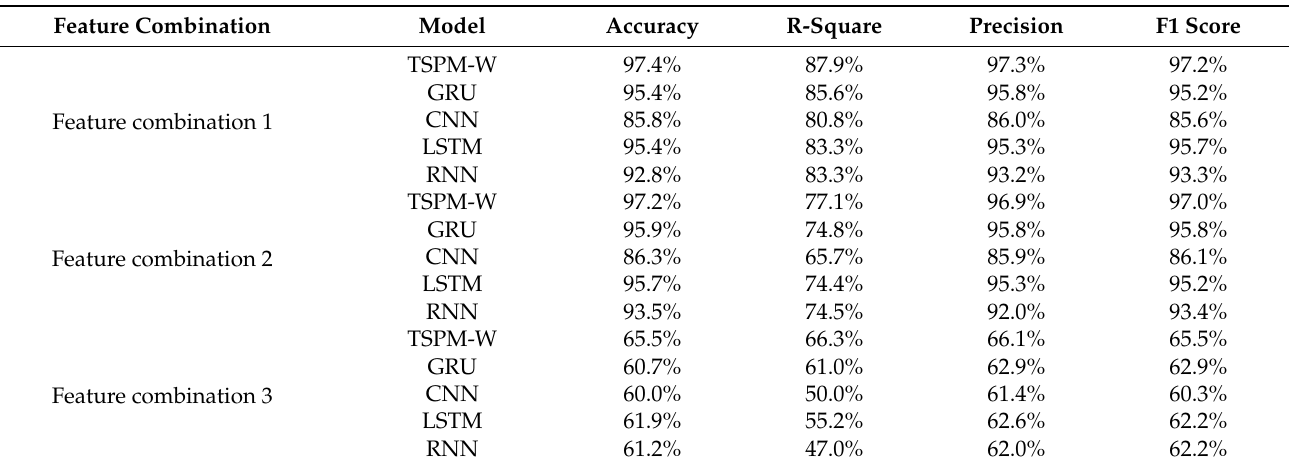
Table 7. Performances of five prediction models.